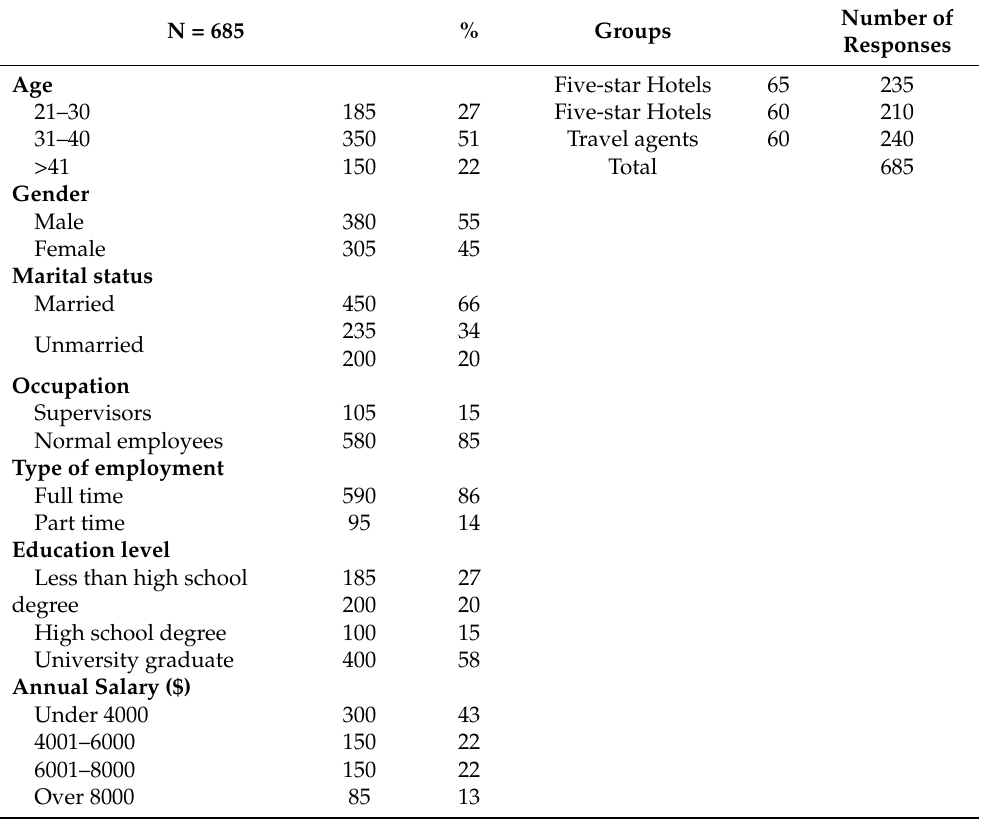
Table 1. The Demographic characteristics (developed by